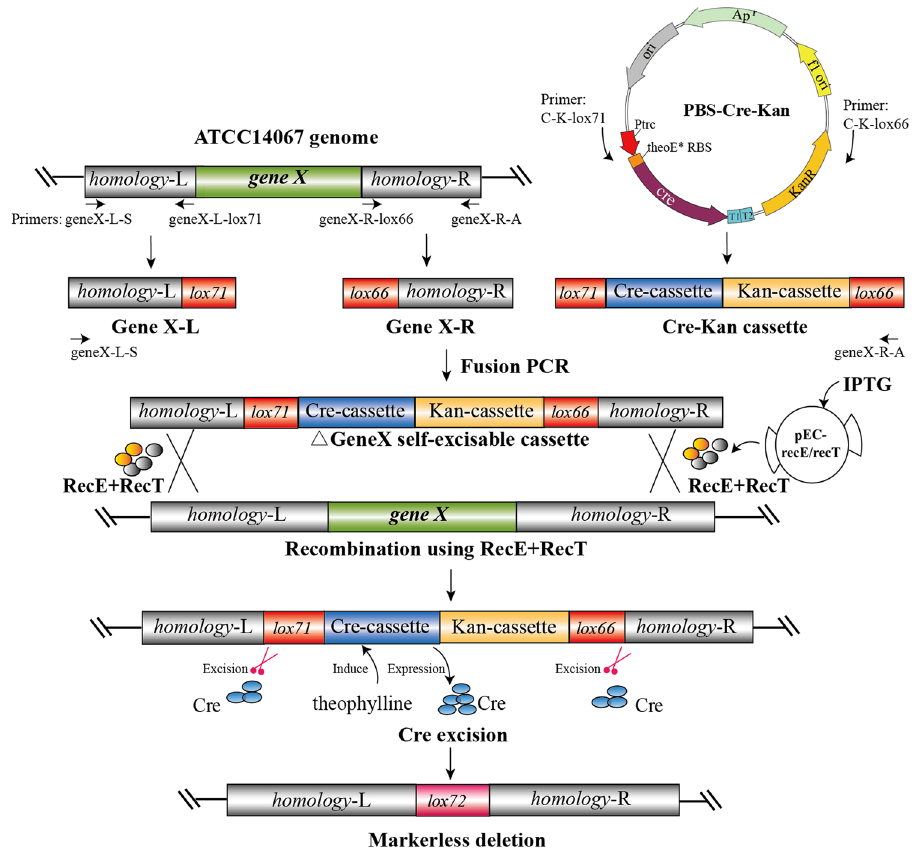
Figure 2. Scheme for gene markerless deletion via a self-excisable cassette in C. glutamicum ATCC14067. The theoE * -RBS is theophylline riboswitch E * which can induce the expression of Cre with 1 mM theophylline. The homology-L/R represents the left/right homology arms of the targeted gene, which are approximately 800 bp. GeneX-L represents the targeted gene’s left homology arm and 34 bp lox71 sequence, and GeneX-R represents the 34 bp lox66 sequence and the targeted gene’s right homology arm. Cre-Kan cassette contains the 34 bp lox71 sequence, the Cre expression cassette, the kanamycin resistance cassette and the 34 bp lox66 sequence. Δ GeneX represents the targeted gene to be deleted. GeneX represents the targeted gene. All primers are listed in Supplementary Table